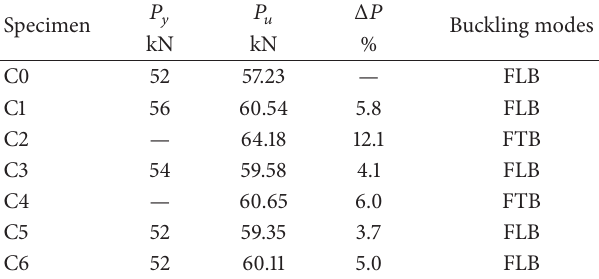
Table 2: Summary of load capacity and buckling modes.